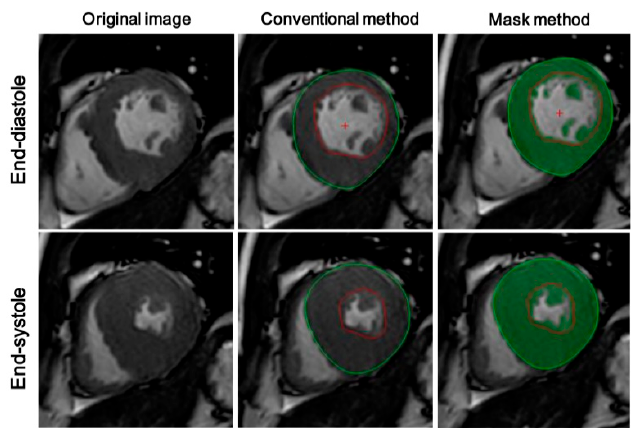
Figure 1. Representative CMR images showing the two methods employed for CMRI analysis. The upper row indicates end-diastolic short-axis view cine images, and the lower row indicates end-systolic images. The middle column demonstrates the conventional method and the third column demonstrates the mask method. In the conventional method, epicardial and endocardial contours of the LV myocardium (excluding papillary and trabecular muscles, PTMs) were traced with the software and corrected manually on each LV short-axis cine image. The area between the green line and the red line indicates myocardium. Then, on the basis of the conventional method, myocardium (including PTMs) was selected with a mask mode using a thresholding algorithm based on the difference of grayscale between the bright blood pool and the dark myocardium. Green parts represent myocardium.